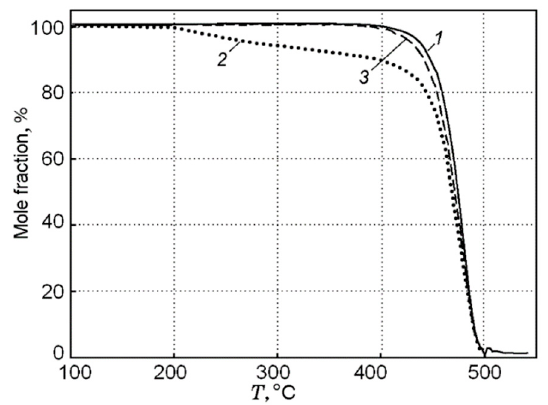
Figure 16. Thermogravimetric curves for UHMWPE (1) and UHMWPE + 10% TPP (2); Curve 3 was obtained from Curve 2 (see the text); the heating rate was 10 K/min.